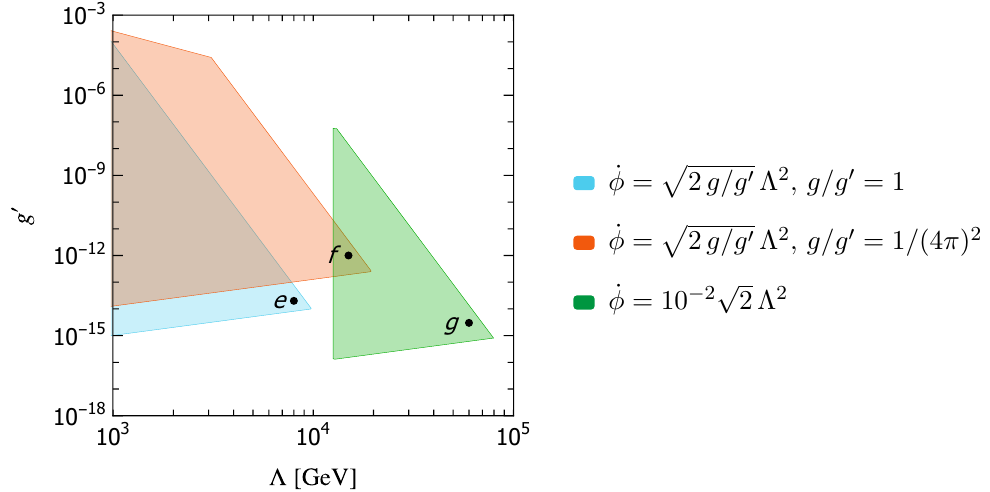
Figure 5 . Parameter space in the plane g 0 ; (cid:3) for the scenarios in which relaxation happens without